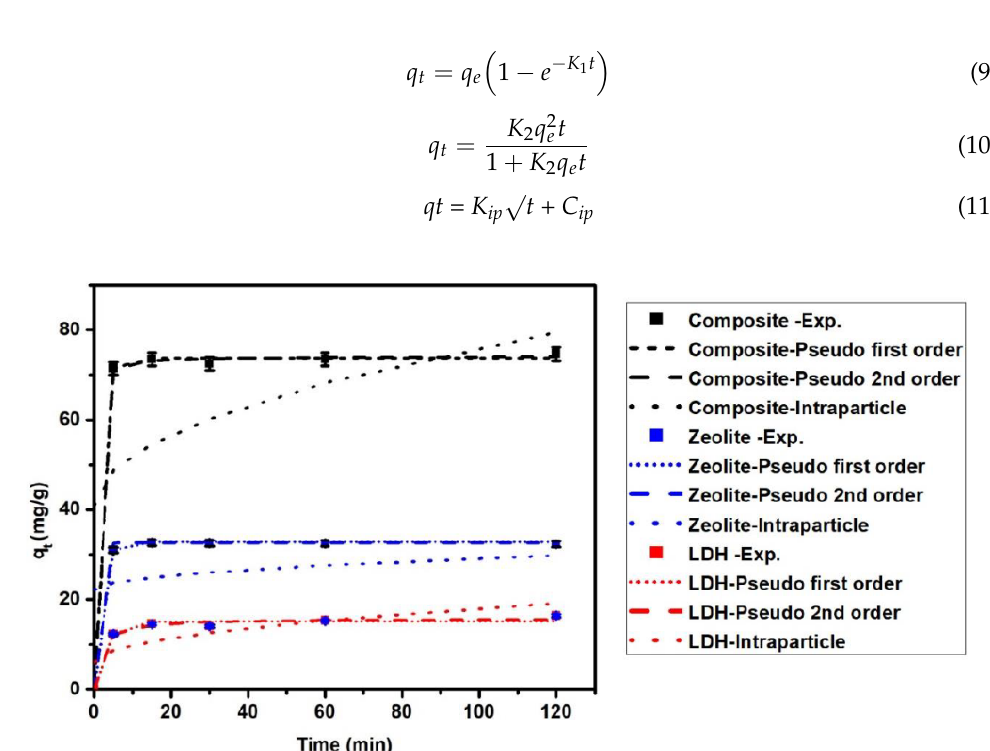
Figure 9. Comparison of adsorption kinetic models with experimental data of MB dye on LDH, zeolite and composite at concentrations 50 mg/L.